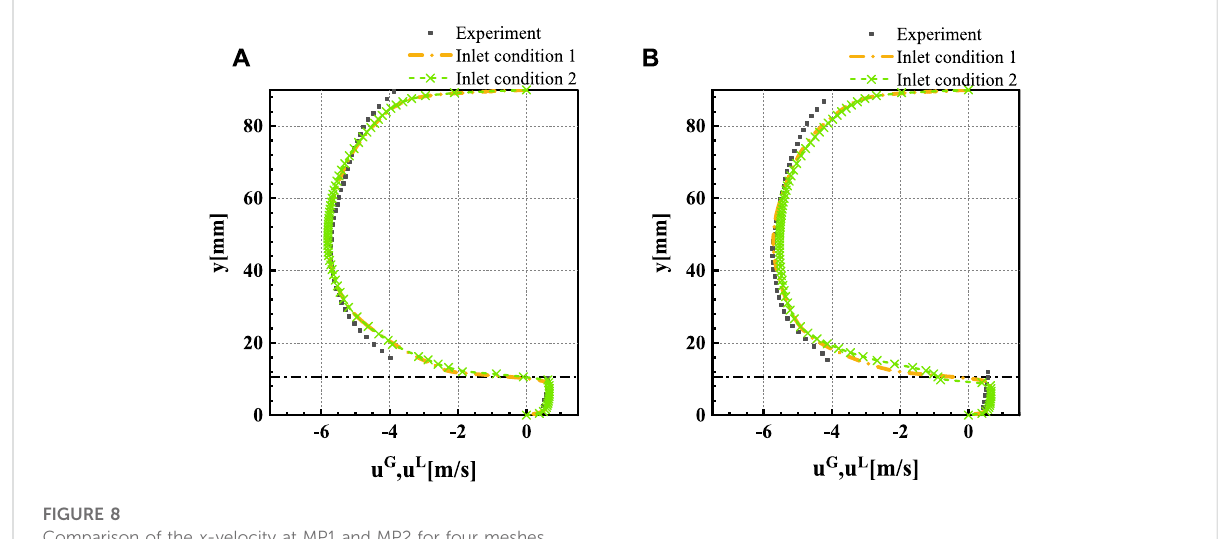
FIGURE 8 Comparison of the x- velocity at MP1 and MP2 for four